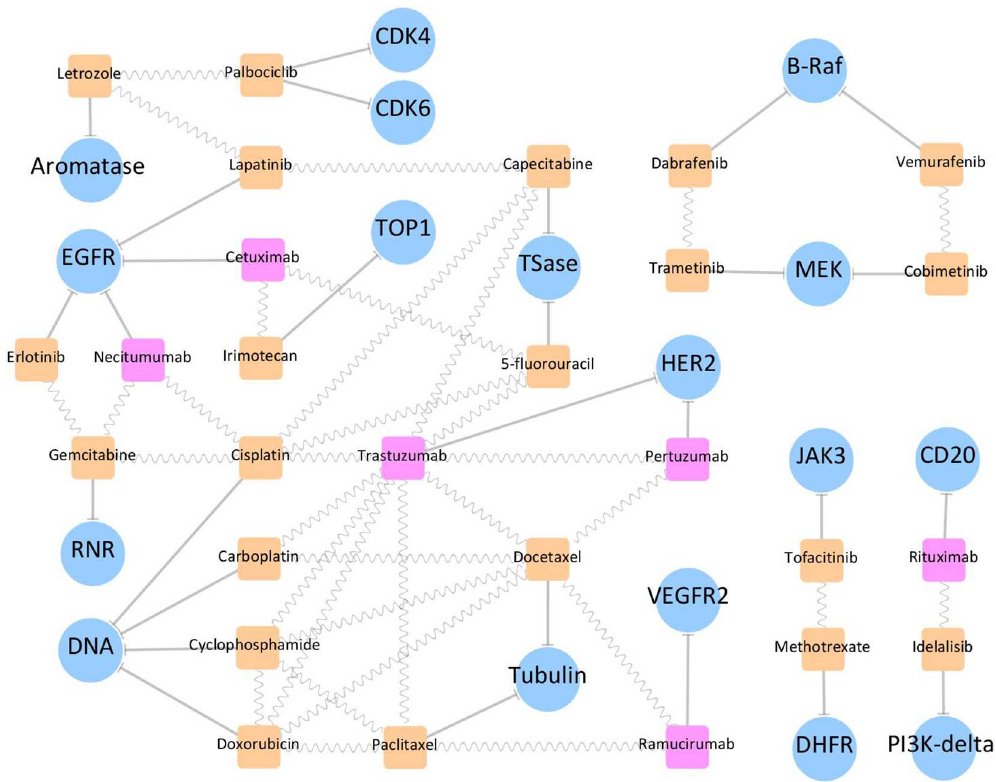
Fig 5. The drug-target interaction network of the FDA approved combination products. Small molecular drugs in a specific combination product were represented by round rectangle in orange, and monoclonal antibodies were shownby round rectanglein magenta. The combination products were shown by round rectangles connected by sine-wave, and targets were shown by blue ellipse.Drug-targetinteractions were displayedby edges with shapes of arrow for activationand “T” for